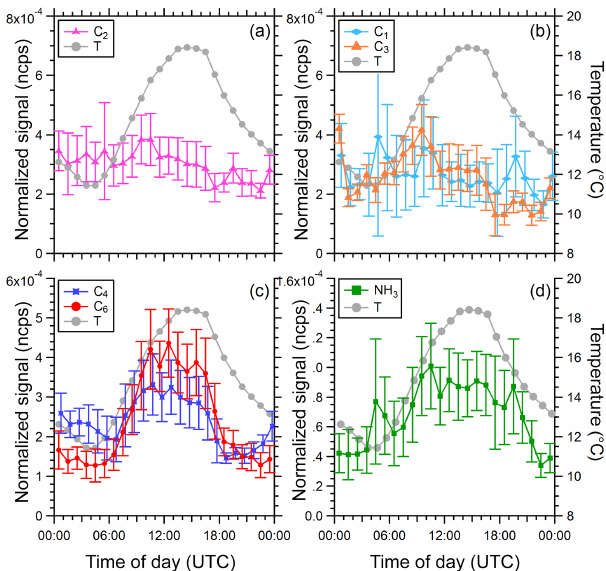
Figure 5. Diurnal averages for different amines (C 1 , C 2 , C 3 , C 4 and C 6 ) and ammonia. The temperature profile is shown in addition. Error bars represent 1 standard deviation of the 30min averages. The lower detection limits for the different compounds are not well defined. However, the lowest measured signals during some periods were 0.3 × 10 − 4 ncps for C 1 ; ∼ 0.5 × 10 − 4 ncps for C 2 , C 3 , C 4 and C 6 ; and 0.1 × 10 − 4 ncps for ammonia. For most of the time (and for all averaged values shown) the signals were clearly above these “background”